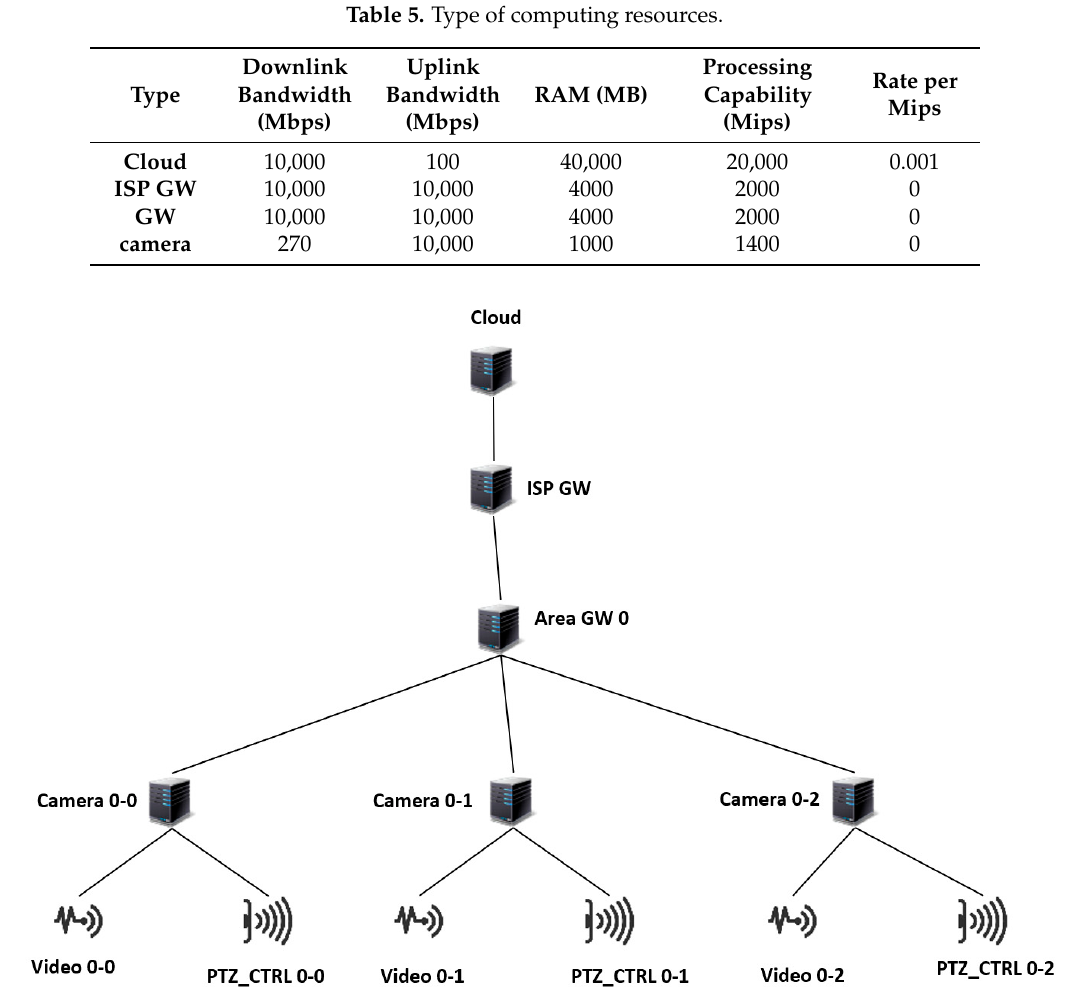
Figure 1. Network topology for one area.